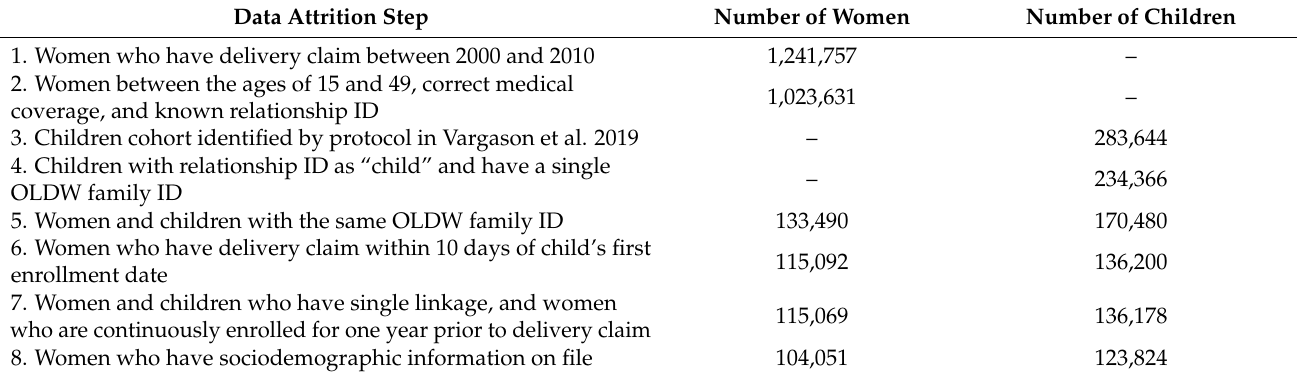
Table 1. Data Attrition Steps for Identifying Mother Cohorts and Associated